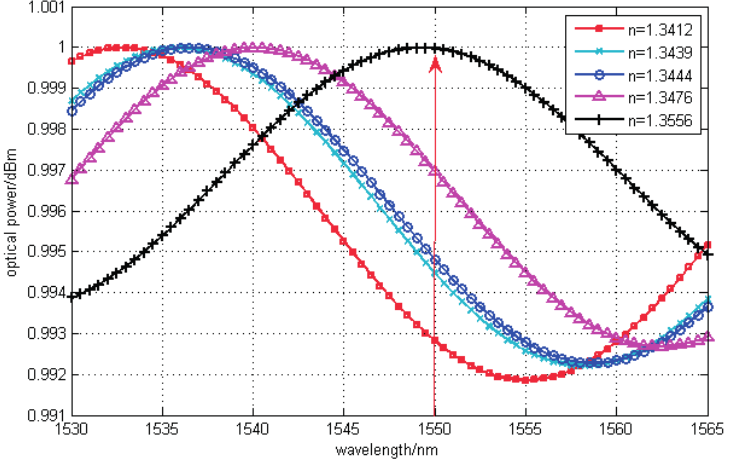
Figure 4. Signals of F-P interference with cavity length of 24 μ